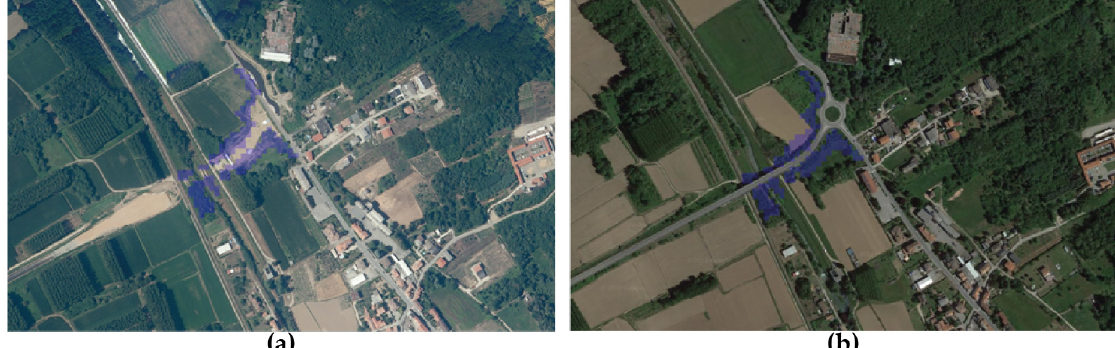
Figure 9. The image shows a road construction site area (reversible consumed land) in Novara between 2012 ( a ) and 2018 ( b ). The central area has been transformed into a paved road (permanent consumed land), while the purple areas have been restored after the completion of the road. In all urban municipalities with a decrease in land consumption, the changes are associated with the restoration of the maneuvering and storage areas surrounding the construction sites of new buildings, roads, and infrastructures.